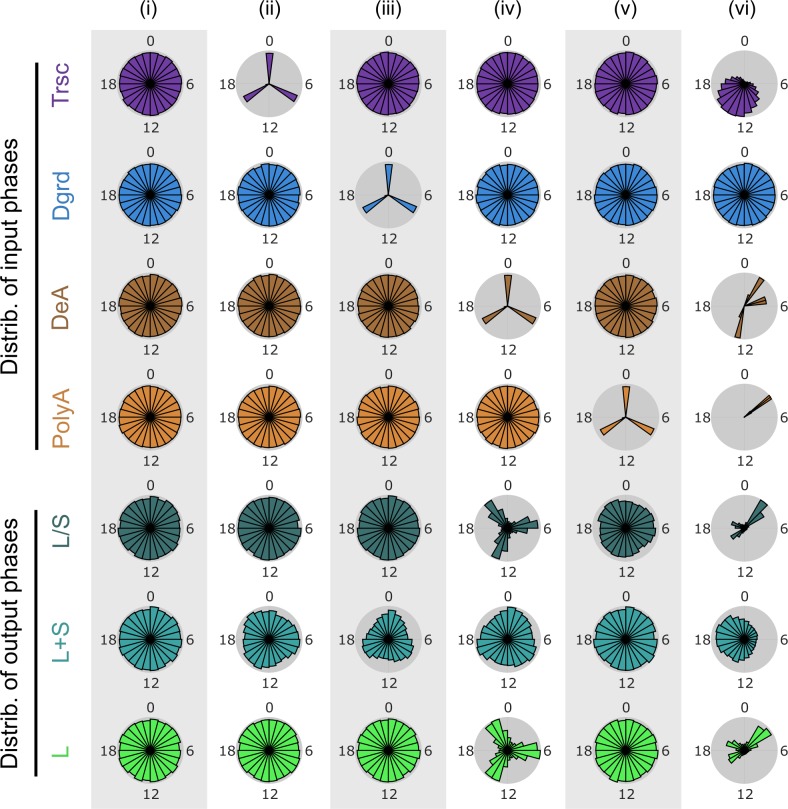
Distinct peak phases in deadenylases cluster transcripts by their peak phases of poly(A) tail length and long-tailed mRNA abundance.(i) Transcription, degradation, deadenylation and polyadenylation phases evenly distributed around the clock. (ii) Transcription phases within three narrow windows at ZT 0, 8, and 16. Degradation, deadenylation and polyadenylation phases evenly distributed around the clock. (iii) Degradation phases within three narrow windows at ZT 0, 8, and 16. Transcription, deadenylation and polyadenylation phases evenly distributed around the clock. (iv) Deadenylation phases within three narrow windows at ZT 0, 8, and 16. Transcription, degradation and polyadenylation phases evenly distributed around the clock. (v) Polyadenylation phases within three narrow windows at ZT 0, 8, and 16. Transcription, degradation and deadenylation phases evenly distributed around the clock. (vi) Peak phases of transcription follow transcriptome data reported by [13]. Deadenylation phases within three narrow windows at ZT 2, 5, and 13, and polyadenylation phases within one narrow windows at ZT 3.5, based on the data from [29], while degradation phases evenly distributed around the clock. Mean rates and relative amplitudes follow Table 1 and S1 Fig.